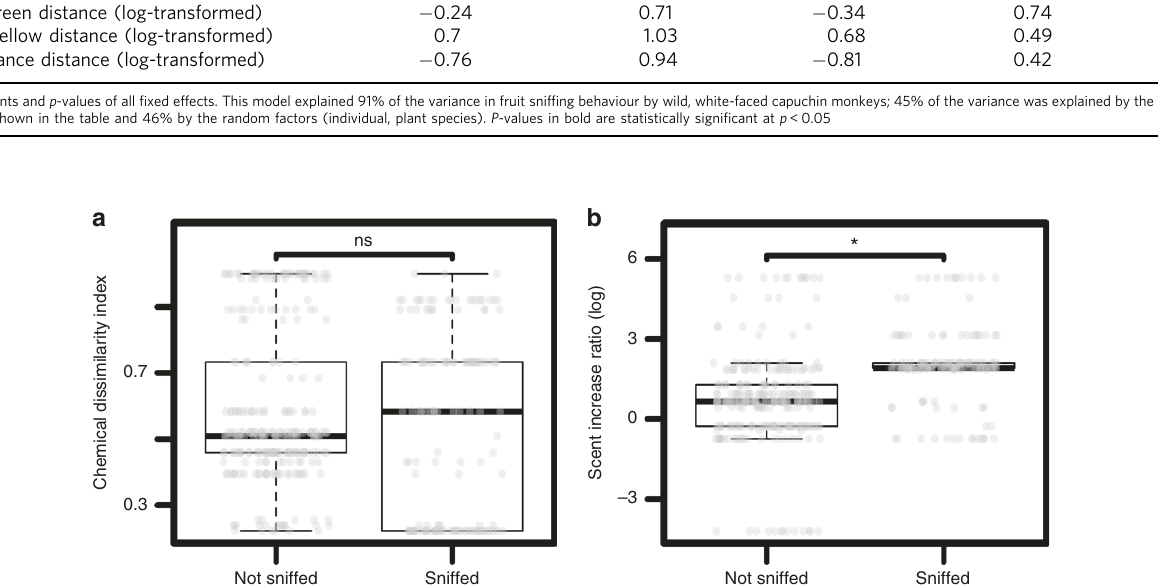
Table 1 Results of generalized linear mixed model Estimate SE z -value p -value Intercept − 1.02 4.51 − 0.23 0.82 Colour vision type (trichromat vs. dichromat)